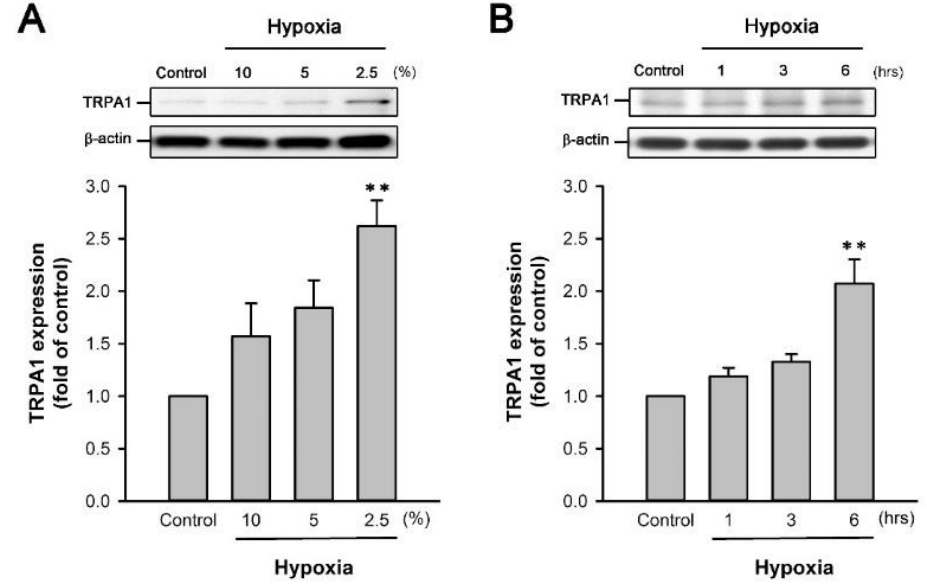
Figure 5. Increase in TRPA1 expression induced by H/R in HK-2 cells. ( A ) HK-2 cells were incubated under normoxia conditions as control or exposed to 2.5%, 5%, or 10% O 2 (hypoxia) for 6 h, followed by 4 h of reoxygenation. ( B ) HK-2 cells were incubated under normoxia conditions as control or exposed to 2.5% O 2 for 1, 3 or 6 h, followed by 4 h of reoxygenation. Protein expression was analyzed by Western blot. Data in each group are mean ± SEM from 6 independent experiments. ** p < 0.01 versus the control group.